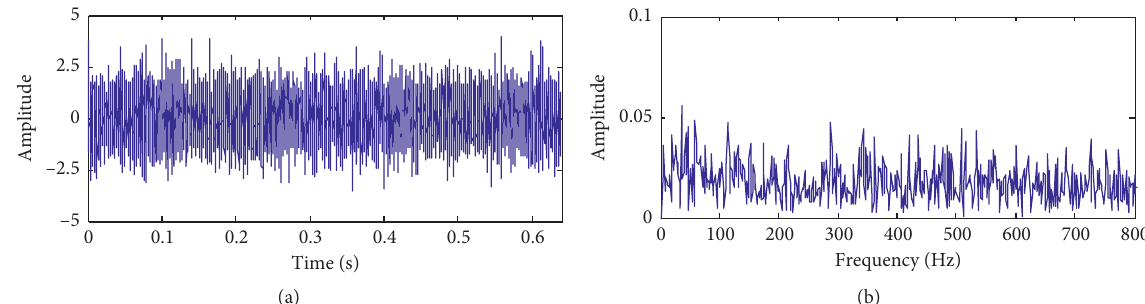
Figure 8: Analysis results of simulated signal by CYCBD with optimal parameters: (a) the waveform of deconvolution signal; (b) the envelope spectrum of deconvolution